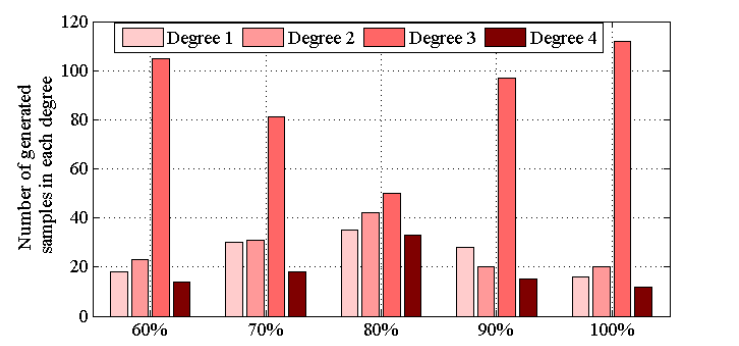
Figure 8. Comparison of degree distribution with different 𝜁